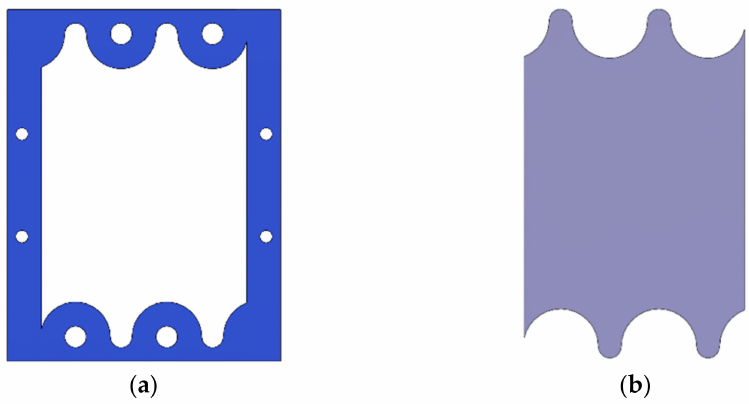
Figure 3. Spacer G1. ( a ) gasket of spacer G1; ( b ) total area of spacer G1.